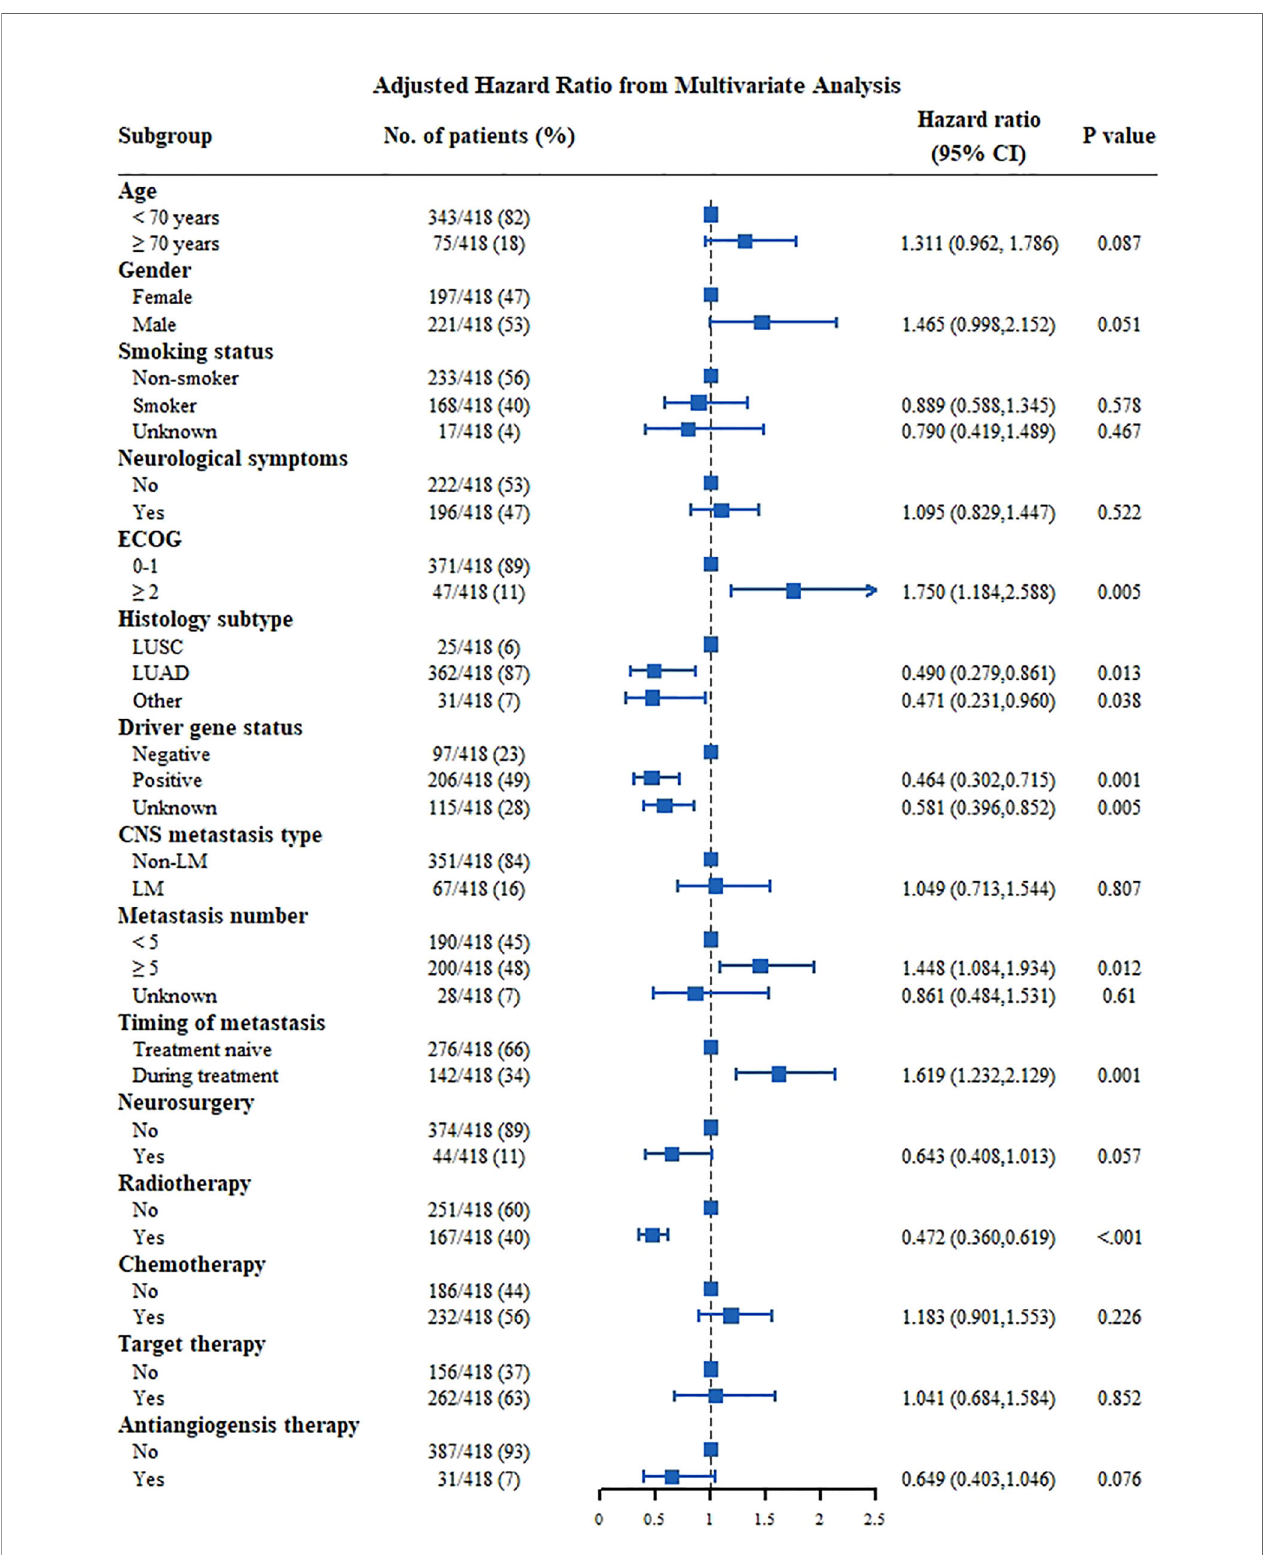
FIGURE 3 | Multivariate analysis Cox proportional hazards for OS in NSCLC patients with CNS metastasis. CNS, central nervous system; ECOG, Eastern Cooperative Oncology Group; LM, leptomeningeal metastasis; LUAD, lung adenocarcinoma; LUSC, squamous cell lung carcinoma.